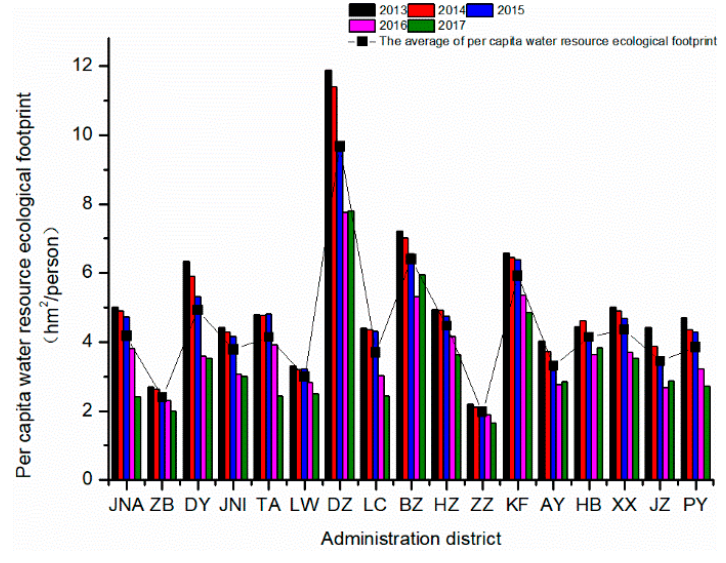
Figure 6. PCWREF of the lower reaches of the Yellow River in 2013–2017.